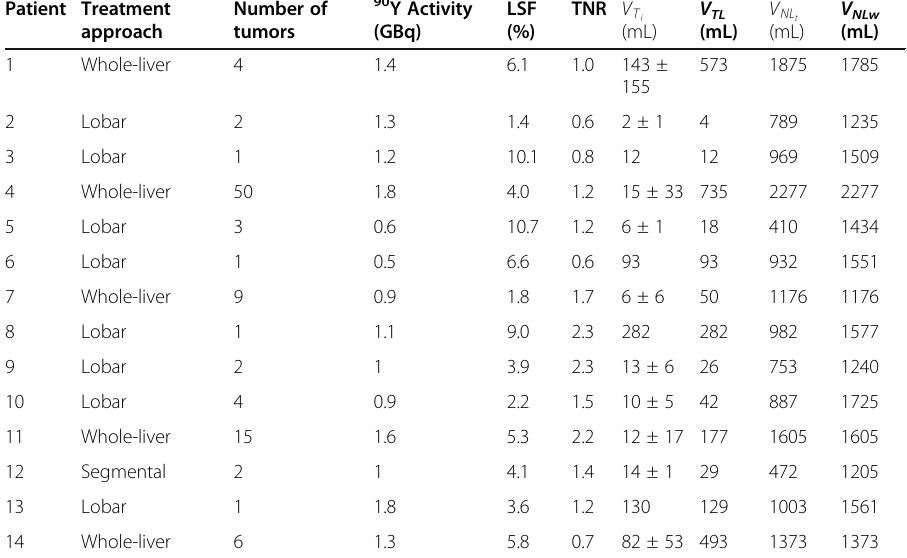
Table 1 Treatment characteristics: treatment approach, number of treated tumors, 90 Y administered activity, the percentage of lung shunt fraction, tumor to non-tumor liver activity concentration ratio, and volumes for individual tumors (average ± SD), aggregated tumoral liver, target normal liver, and whole normal liver Patient Treatment